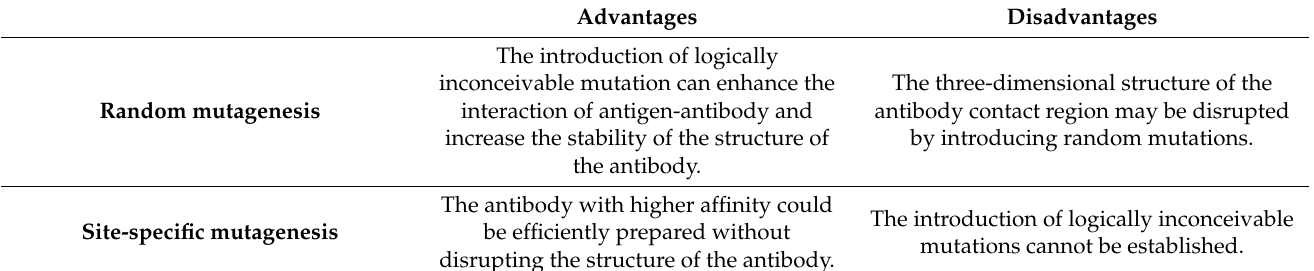
Table 2. Advantages and disadvantages of random mutagenesis and site-specific mutagenesis for constructing gene libraries with mutations.